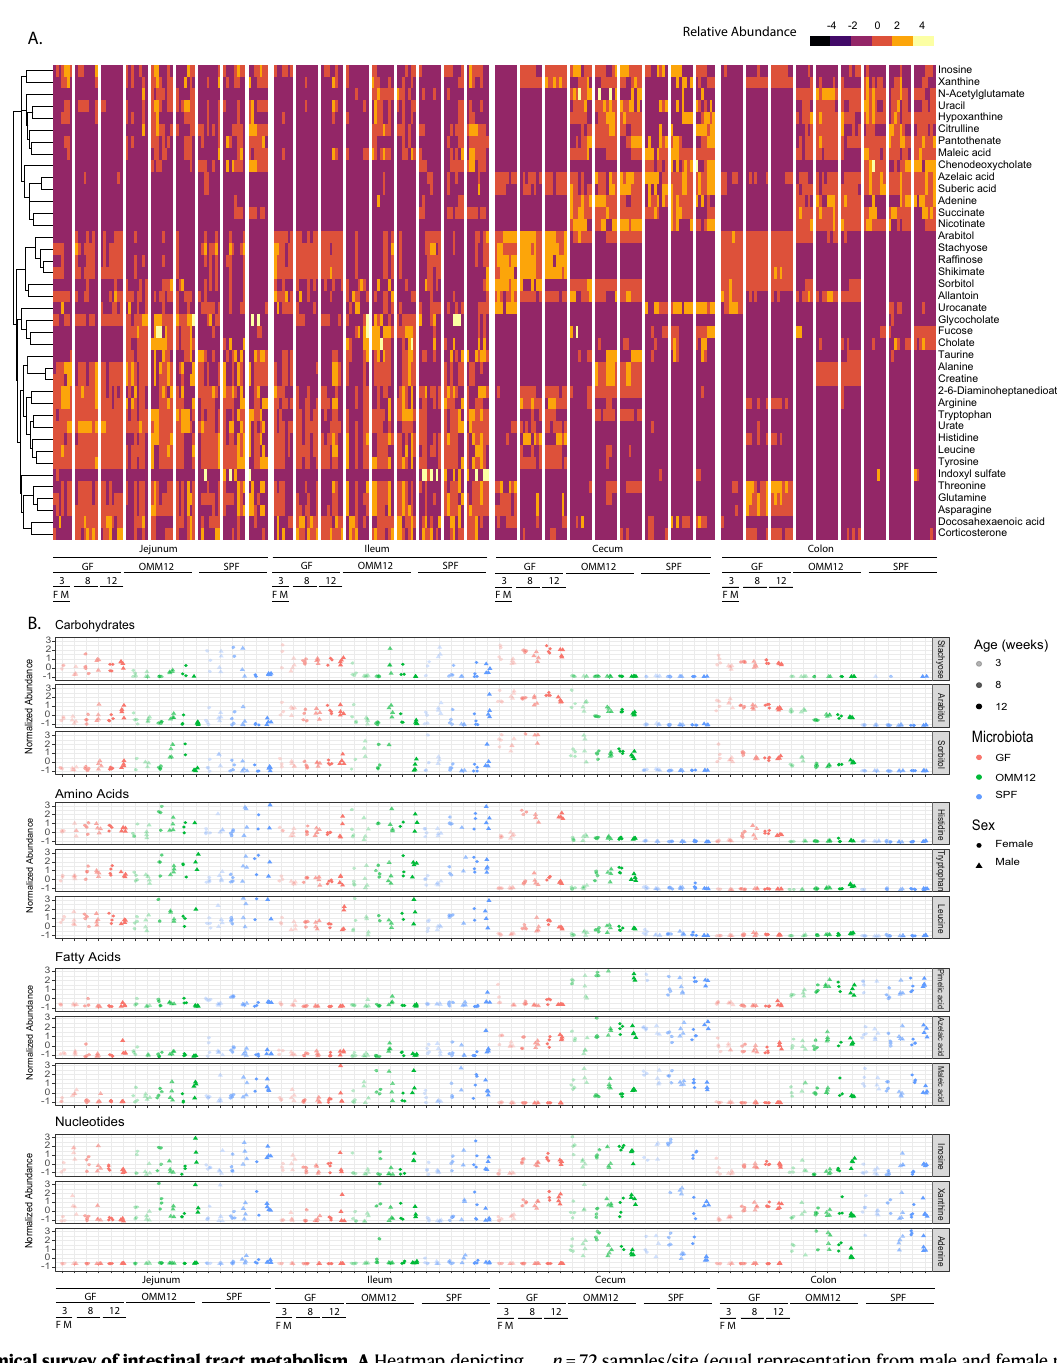
n =72 samples/site (equal representation from male and female mice, GF, OMM12 and SPF colonized mice and 3-, 8- and 12-week-old mice). GF germ-free, OMM12 Oligo-MM12, SPF speci fi c pathogen free, M male, F female. Source data are pro- vided as a Source Data fi